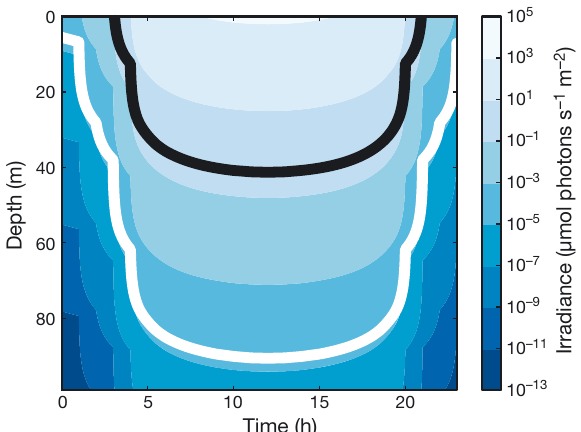
Fig. 4. Simulated (a) temperature and (b) salinity profiles at the outer part of the Hardangerfjord. Diurnal mean from 15 March and 15 May from the model NorKyst800 (green and red lines; 800 m resolution) and the fjord model (blue